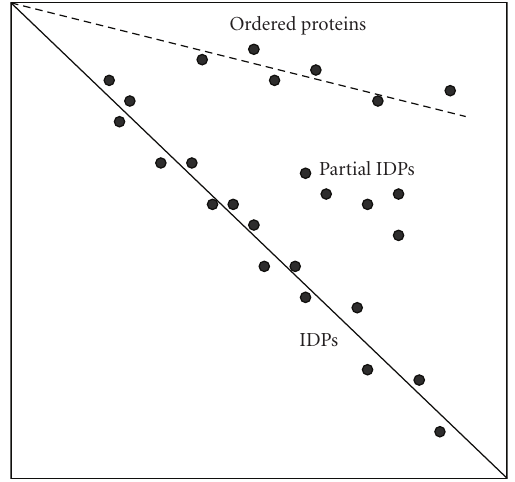
Figure 4: Schematic representation of the native/8 M urea 2D electrophoresis for separation of extended IDPs and globular proteins. A continuous line marks the diagonal of the gel to where IDPs run. A dashed line marks the position of globular proteins. A few proteins with a mixture of ordered and disordered regions are also indicated as “Partial